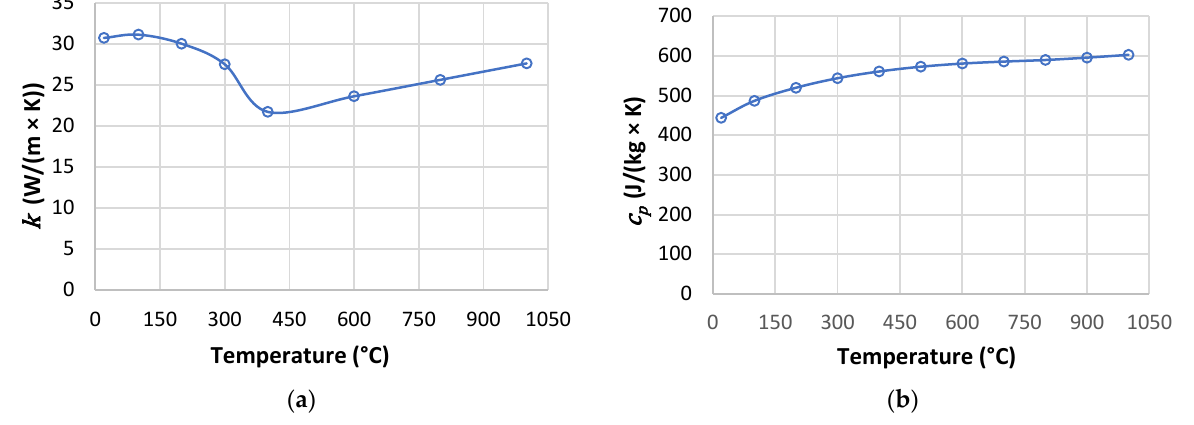
Figure 2. Thermal conductivity ( a ) and specific heat ( b ) functions. 𝑄 𝑗𝑜𝑢𝑙𝑒 , in Equation (1), represents the heat generated by the Joule effect and it can be